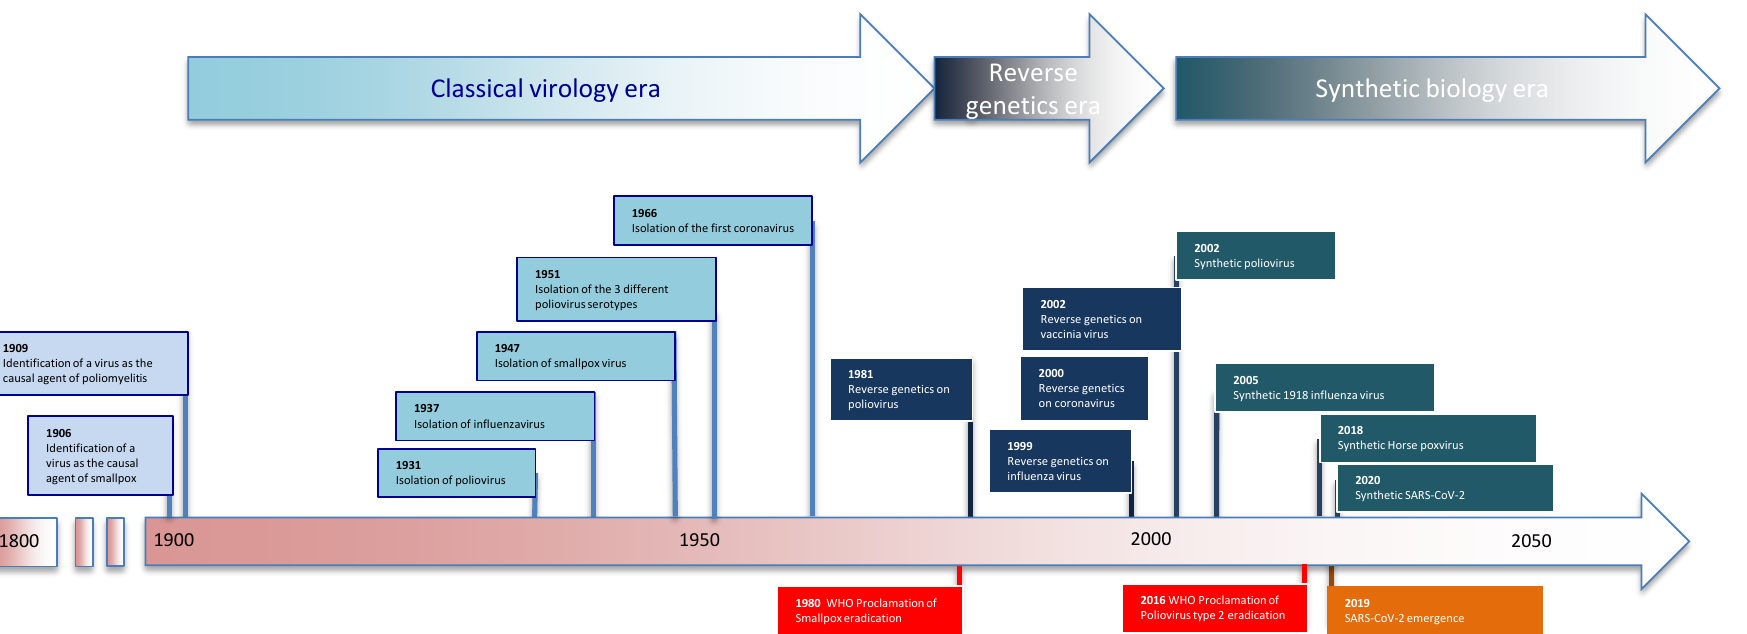
Figure 1. The light blue rectangles are virus discoveries, dark blue rectangles are for reverse genetics-based discoveries, and blue-green rectangles are for virus synthesis. The orange rectangle represents virus emergence, while red is for viral eradication as declared by the World Health Organization